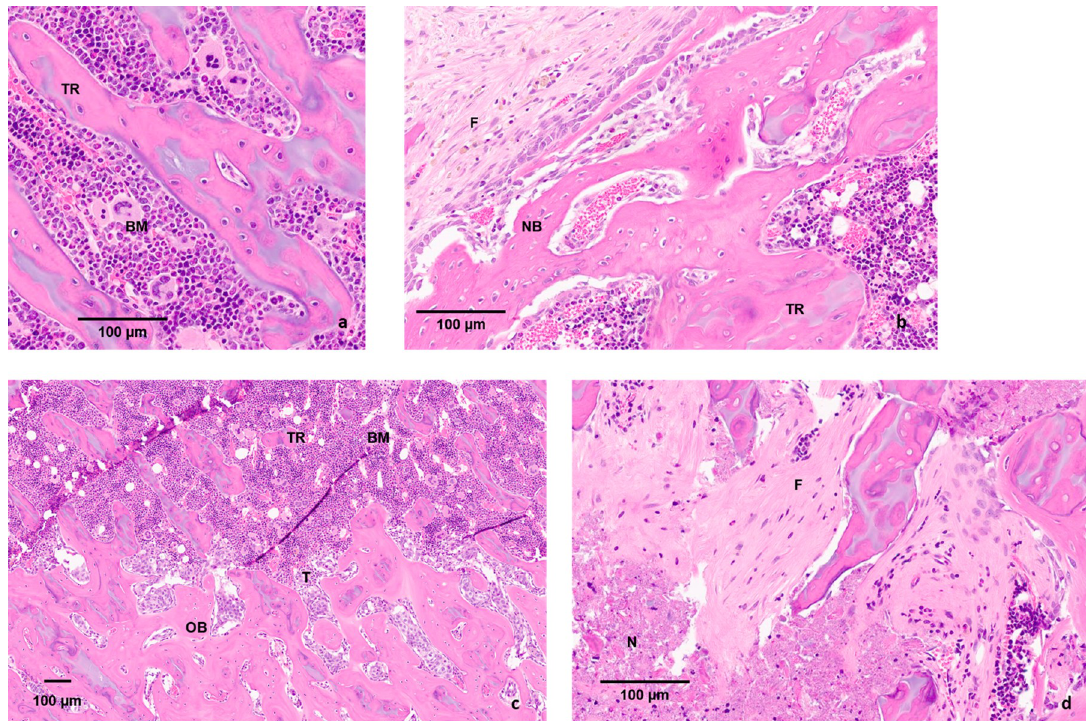
Fig 3. Histopathology of healthy bone tissue. Histology section of the femur of healthy control rats and rats with osteoblastic lesions: a) Mid-sagittal section of a distal femur in a healthy control rat stained with haematoxylin and eosin (BM: bone marrow; TR: trabeculae) b) Mid-sagittal section of a distal femur 4-week post RFA. Fibrous tissue (F) has formed within the treated region with the newly formed bone (NB) visible on the border of the treated area. c) Tumor cells (T; ZR-75-1) in the mid-sagittal section of a distal femur inducing osteoblastic bone formation (BM: bone marrow; TR: trabeculae; OB: osteoblastic bone formation) d) Mid-sagittal section of a distal femur 4 weeks post RFA. Tumor cells are necrotic (N) and fibrous tissue (F) has formed within the treated area.